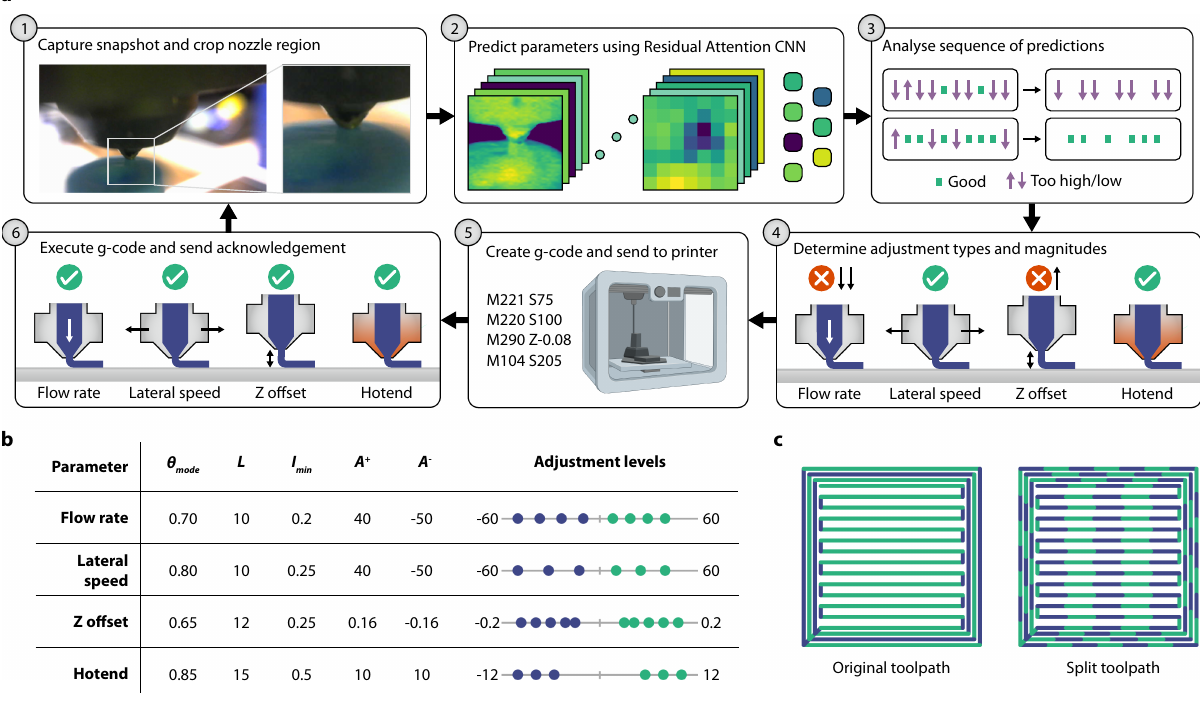
A − (largest decrease) for each printing parameter along with the possible levels of Fig.3|Machinevisioncontrolsystempipelineandfeedbackparameters.a The six major steps in the feedback pipeline enable online parameter updates from update amounts. c Simple example single layer geometry illustrating toolpath images of the extrusion process. b Table containing θ mode (mode threshold), splitting into equal smaller segments. 1mm lengths are used in the feedback pro- A + (the largest increase), L (sequence length), I cess to enable rapid correction and reduce response min (interpolation minimum),